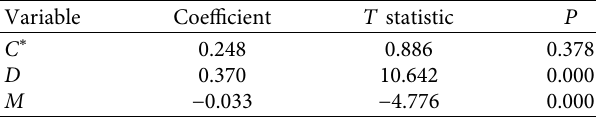
Table 2: Significance of coefficients (acceleration peak involved).